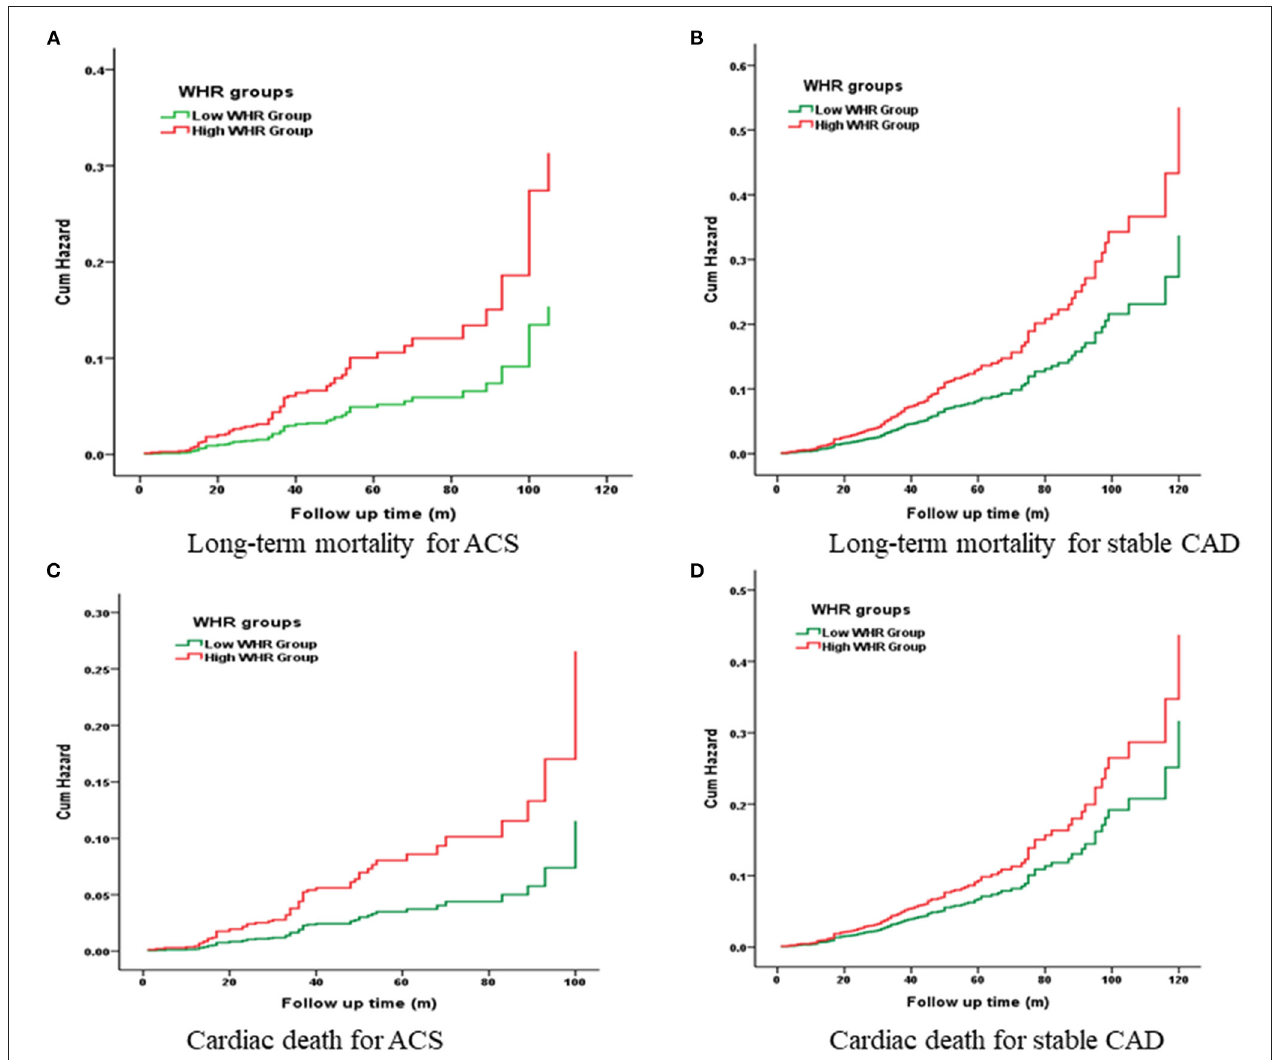
FIGURE 2 | Cumulative Kaplan-Meier estimates of the time to the first adjudicated occurrence of primary endpoint and secondary